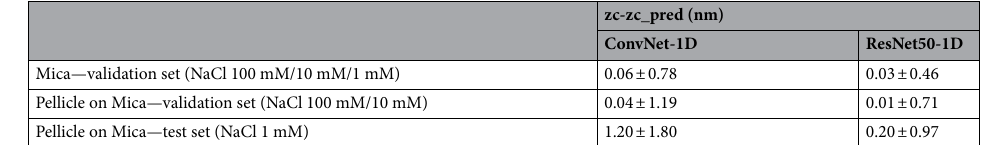
Table 1. Mean and standard deviation values for the difference between the sample positions of the labelled and predicted (by the two networks used in this work) contact points for all validation and test data